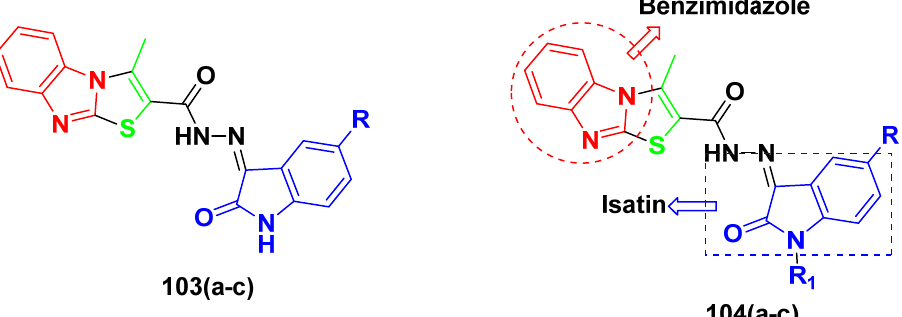
Figure 98. Structure of isatin-thiazolo benzimidazole derivatives ( 103 , 104 ).